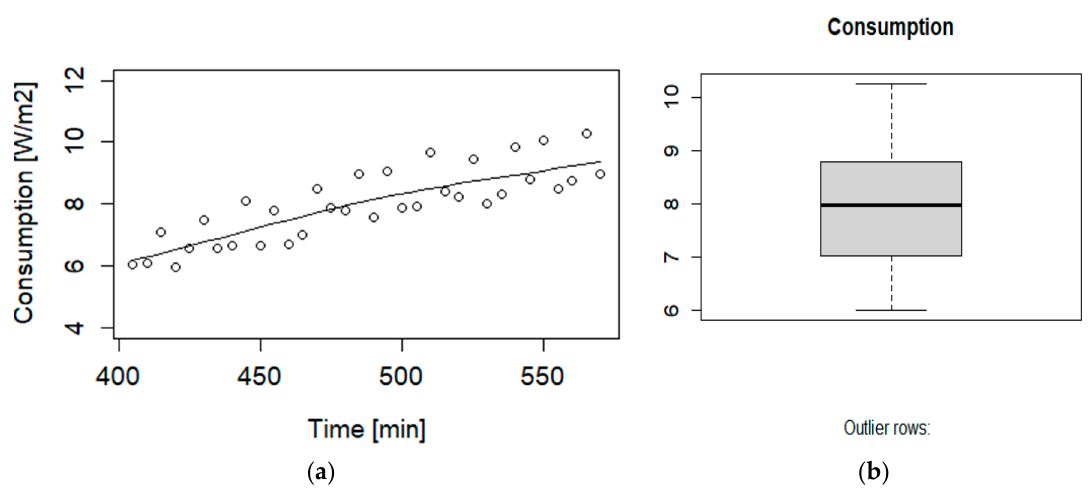
Figure 4. Arriving-at-work period (6:45–9:30): ( a ) Scatter plot; ( b ) Box plot.